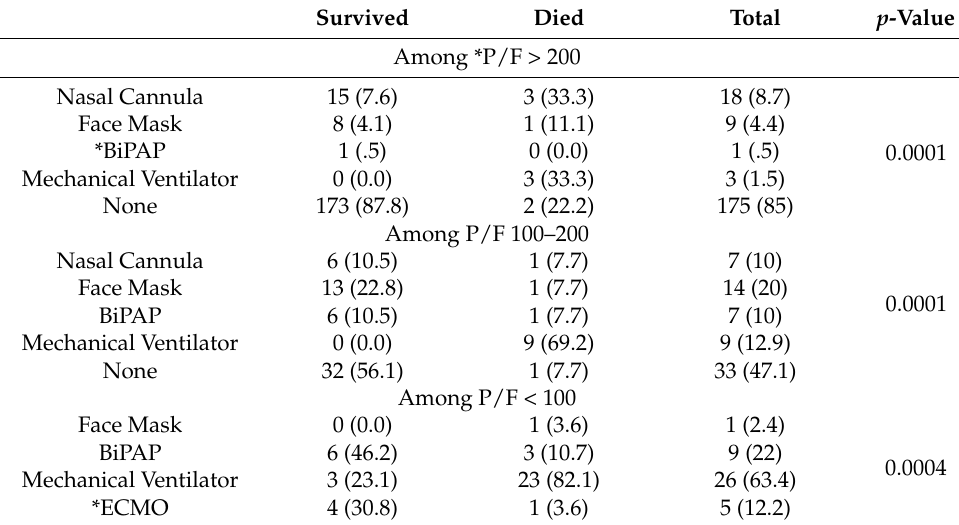
Table 5. Cross-tabulation of P/F ratio and